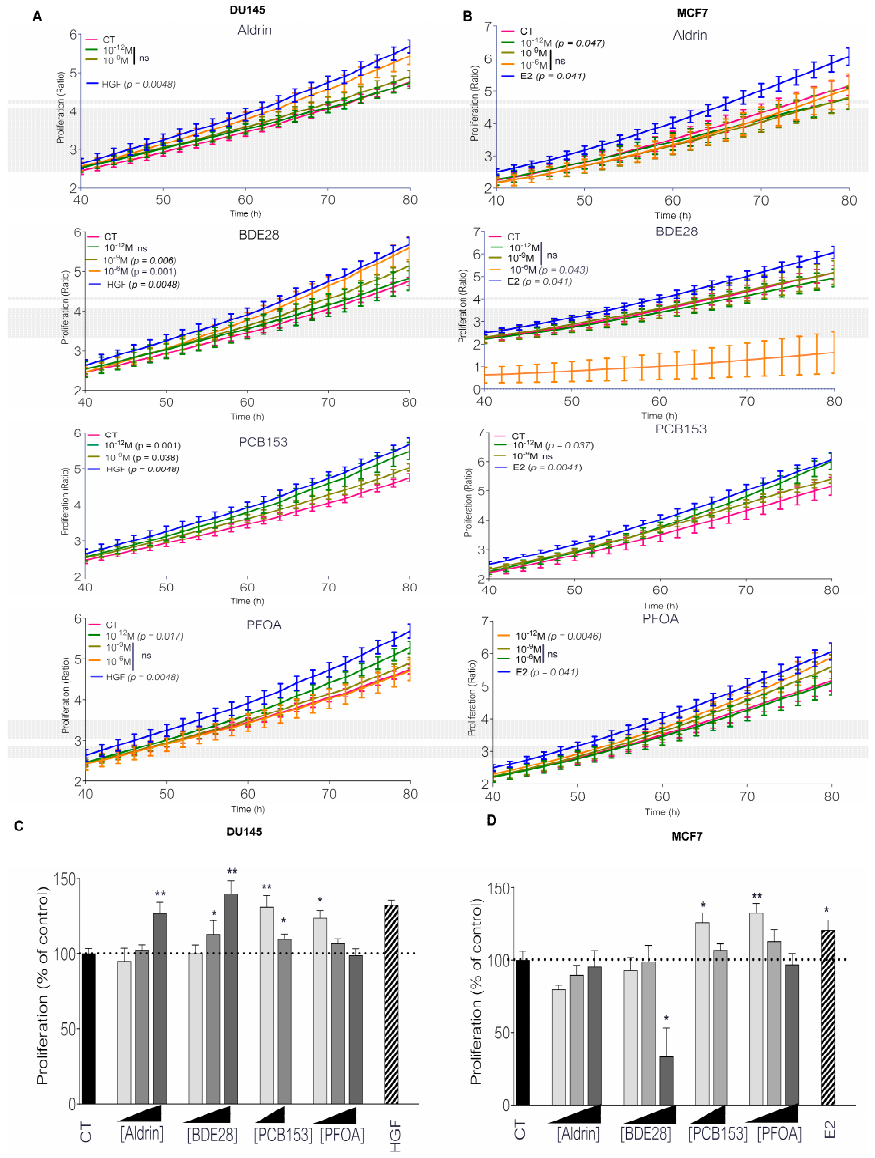
Figure 1. Persistent organic pollutants affect MCF7 and DU145 cell proliferation. ( A , B ) IncuCyte ® proliferation assay in DU145 and MCF7 cells infected with NucLight red lentivirus, after treatment of 80 h with either aldrin (10 − 12 M, 10 − 9 M or 10 − 6 M), BDE28 (10 − 12 M, 10 − 9 M or 10 − 6 M), PCB153 (10 − 12 M or 10 − 9 M) or PFOA (10 − 12 M, 10 − 9 M or 10 − 6 M) in comparison with cells treated with EtOH (CT). Each point represents a mean ± SEM of 3 independent experiments. ( C , D ) IncuCyte ® proliferation assay. Slope between 48 h and 72 h of simple linear regression line of IncuCyte ® proliferation curve of MCF7 and DU145 cells after treatment with either aldrin (10 − 12 M, 10 − 9 M or 10 − 6 M), BDE28 (10 − 12 M, 10 − 9 M or 10 − 6 M), PCB153 (10 − 12 M or 10 − 9 M) or PFOA (10 − 12 M, 10 − 9 M or 10 − 6 M) in comparison with cells treated with EtOH (CT). Estradiol (E2, 10 − 9 M) and HGF (10 ng/mL) were used as positive control for MCF7 or DU145 cells, respectively. Each bar represents a mean ± SEM of 3 independent experiments. T test. * p < 0.05; ** p <